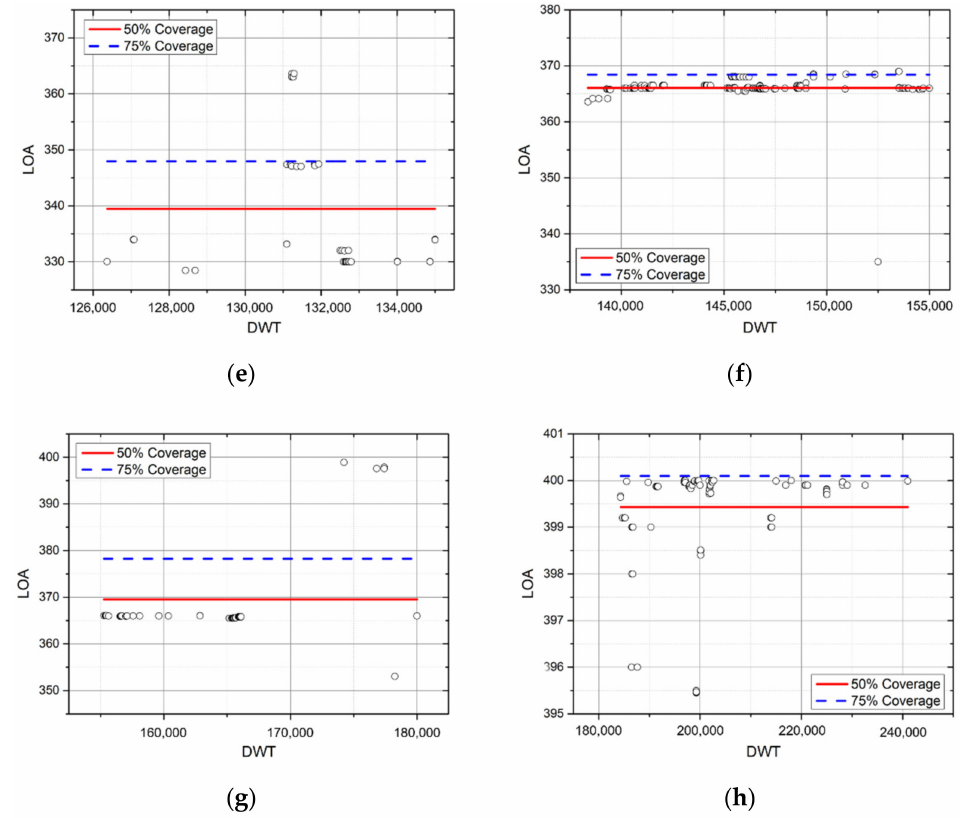
Figure 12. Results of regression analysis. ( a ) Deadweight tonnage (DWT)-length overall (LOA) graph of Cluster 1 (0–55,000 DWT); ( b ) Log(DWT)-Log(LOA) graph of Cluster 1 (0–55,000 DWT);